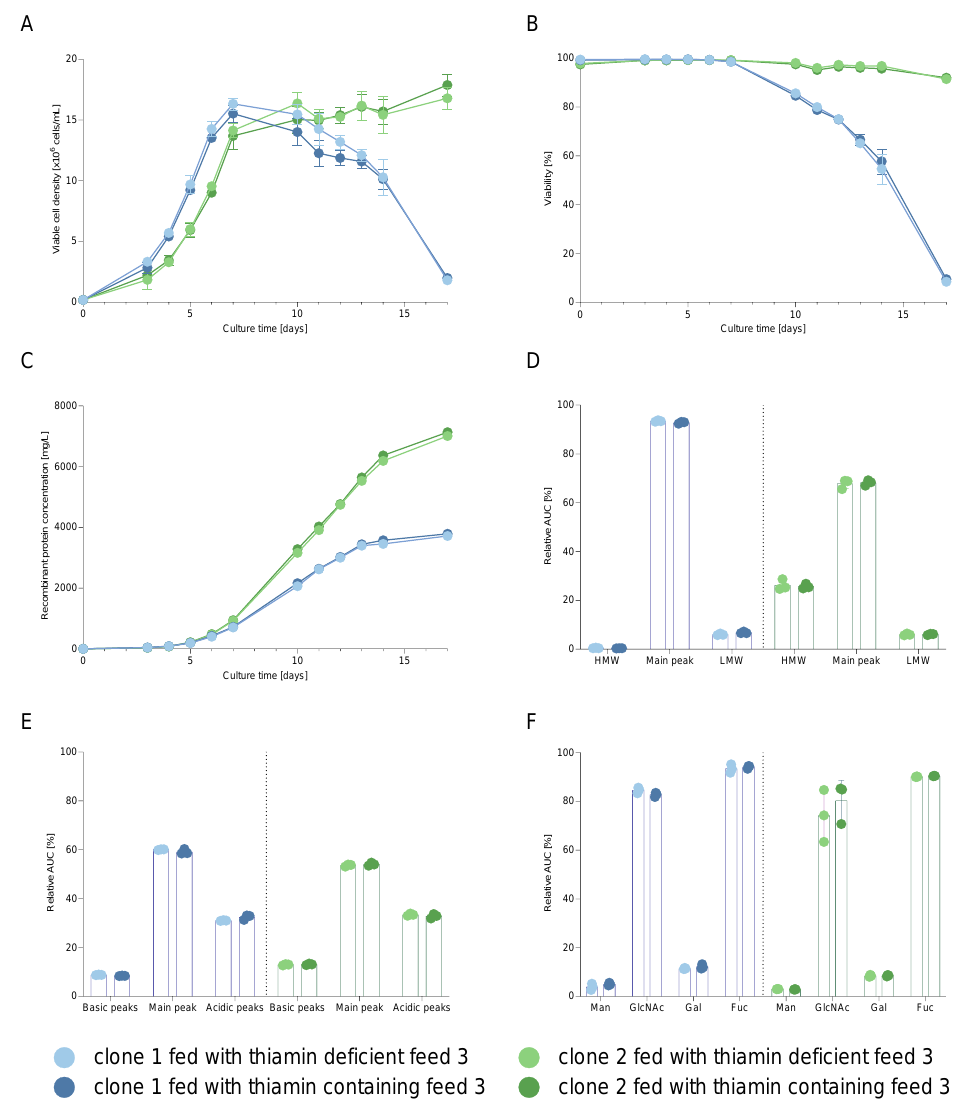
Figure 4. Cell performance of clone 1 and 2 during the FB and day 12 cQA analysis of mAb1 and mAb2. ( A ) Viable cell density, ( B ) viability, ( C ) titer, ( D ) relative quantification of intact recombinant protein and total low as well as high molecular weight forms (LMW, HMW), ( E ) relative quantification of charge variants, and ( F ) relative quantification of total fucosylation (Fuc), total high-mannose (Man), total galactosylation (Gal), and total N-acetylglucosamine (GlcNac) species. n cell performance = 4 and n cQAs = 3, error bars represent standard error of the mean. Similarly to the cell performance, cQAs were not affected by the utilization of a thia- min-deficient feed. For instance, as presented in Figure 4D, a comparable aggregation pro- file was observed with an intact main peak on day 12 above 90% and 65% for mAb1 and mAb2, respectively. Charge variants of recombinant proteins produced with both pro- cesses were also similar, for instance, with 8.8% and 8.4% basic, 60.1% and 59.1% main, and 31.0% as well as 32.4% acidic species for mAb1 produced in clone 1 fed with the thia- min-deficient or the thiamin-containing feed respectively on day 12 (Figure 4E).